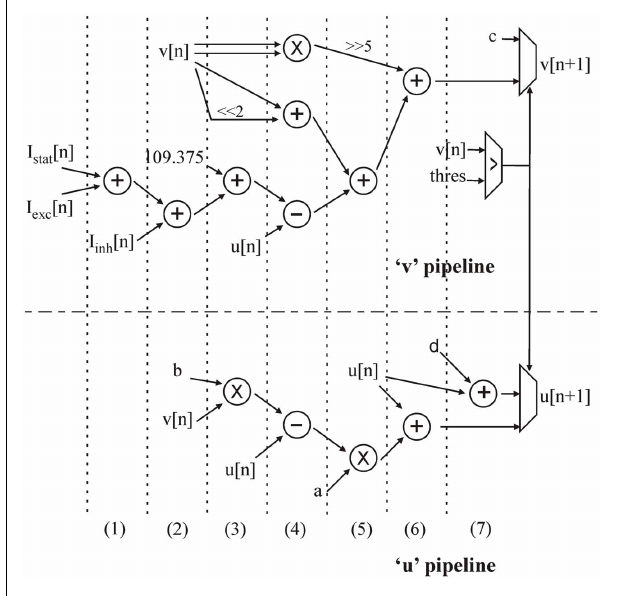
FIGURE 2 | Architecture of the “u” and “v” pipelines in the neural computation core. The computation cycles are separated by dotted lines.